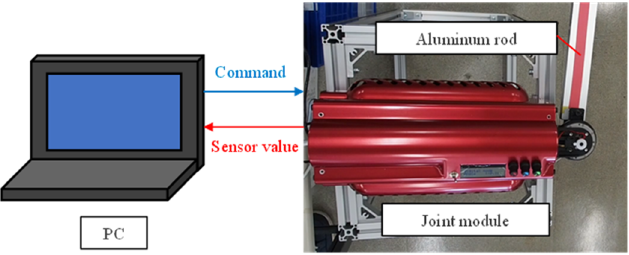
Figure 6. Diagram of the experimental environment for elastic element experiment.